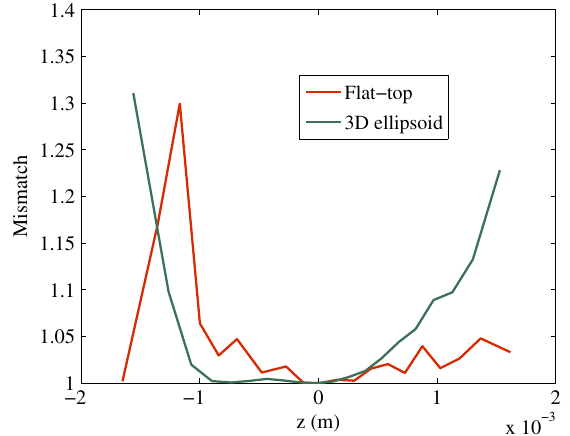
FIG. 13. Mismatch parameter along the bunch for the 3D ellipsoid and the flat-top optimized laser distribution.